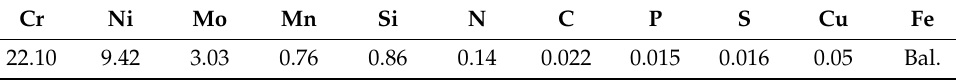
Table 2. Chemical composition of the E2209 filler rod (in wt.%). Cr